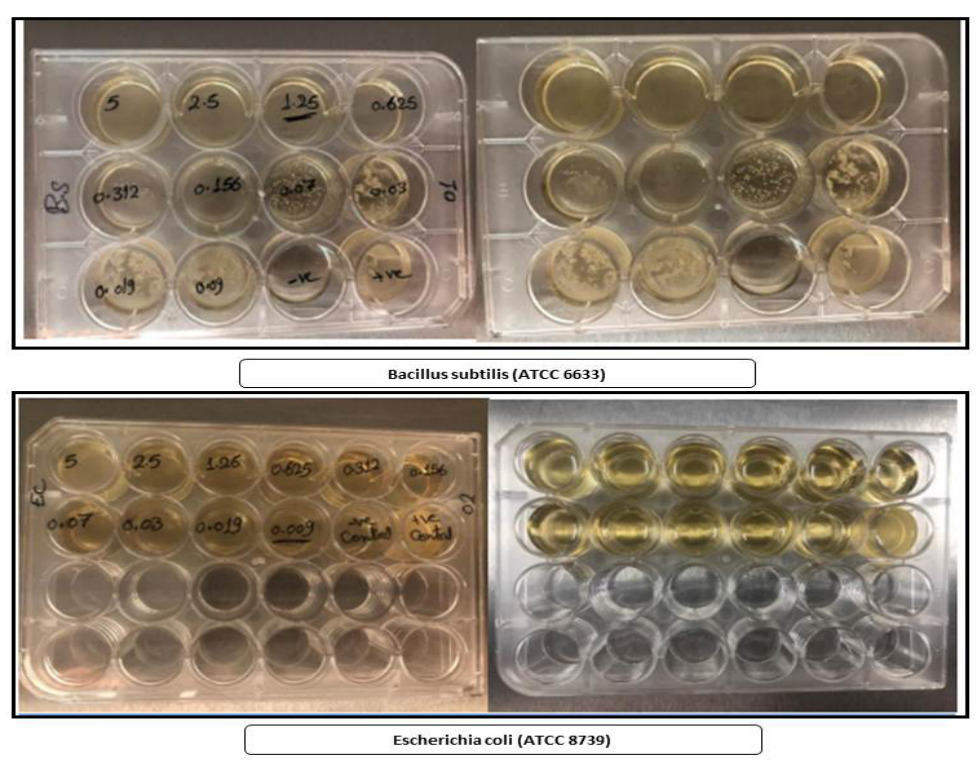
Figure 13. Cefotaxime and cefotaxime metal complexes vs. Bacillus subtilis (ATCC 6633) and Escherichia coli (ATCC 8739). Table 7. Dilution concentration (mg/mL sample) and bacterial inhibition concentration of cefotaxime and its metal complexes (three